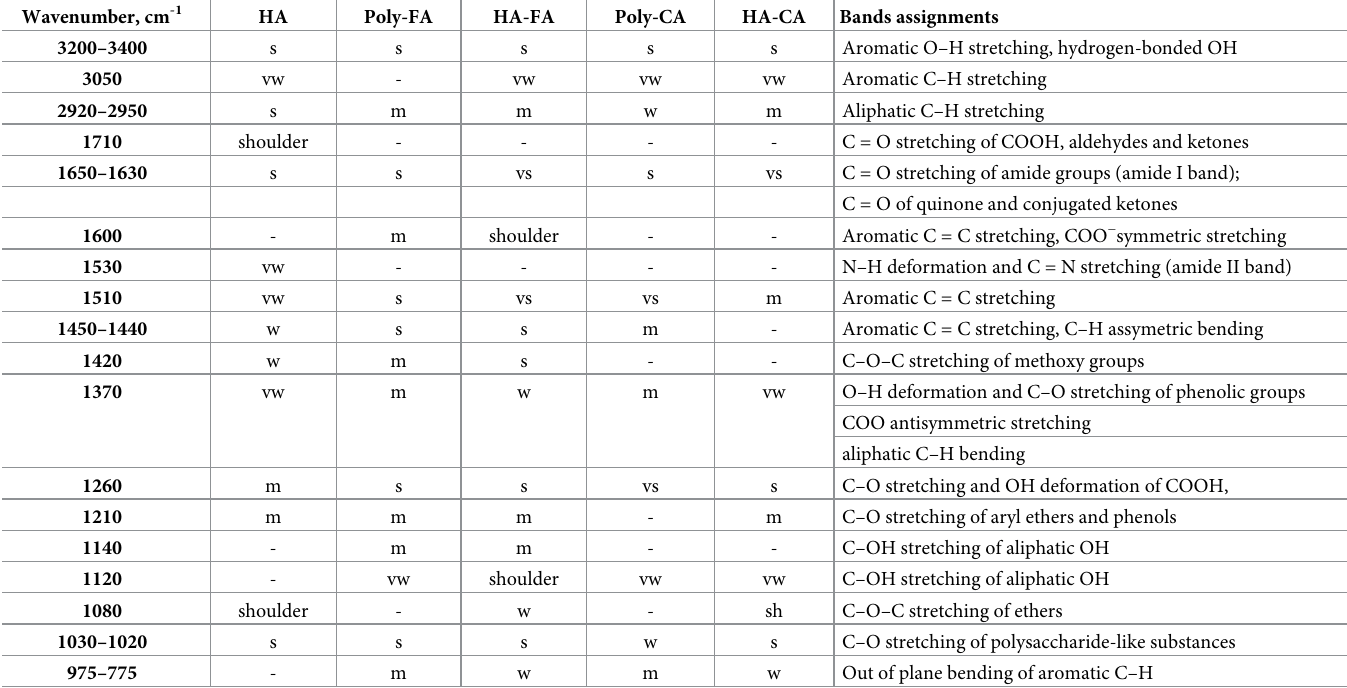
Table 2. Absorption bands and their relative intensity in the IR spectra of the HA, polyphenolic acids and HA-phenolic acid polymers a . Wavenumber, cm